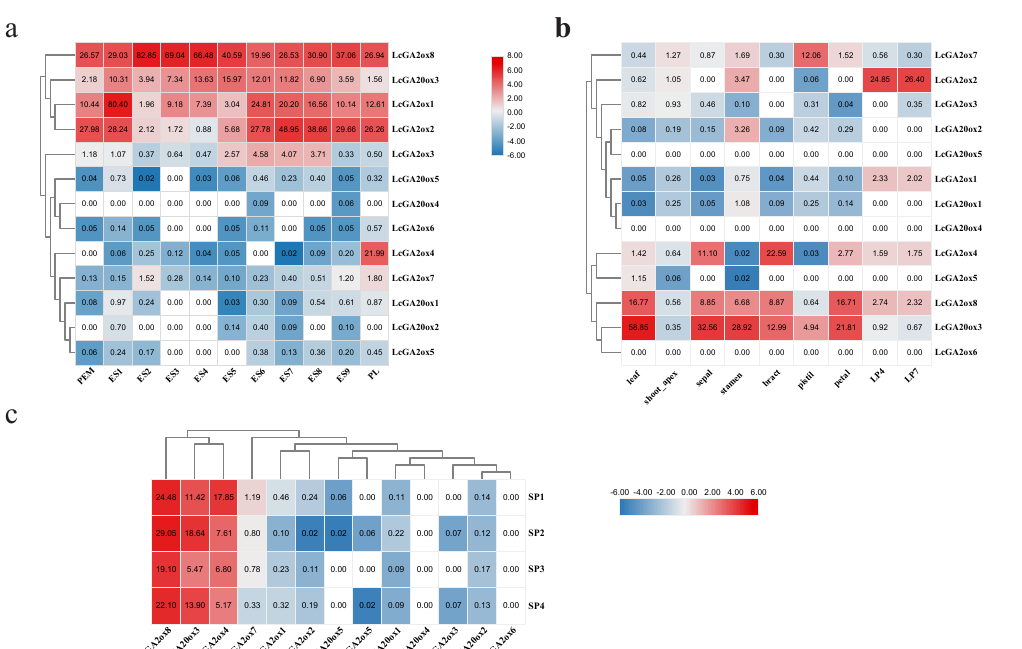
Figure 9. The LcGA20ox and LcGA2ox gene expression profiles in different organs. Two or three biological repeats were shown in the heatmap except bract. The transcripts per million (TPM) was used to indicated the gene expression level. PEM: embryogenic callus; ES1: after 10 days of liquid culture; ES2: two days after sieving; ES3: one day after ABA treatment; ES4: three days after ABA treatment; ES5: globular embryo; ES6: heart shaped embryo; ES7: torpedo embryo; ES8: immature cotyledon embryo; ES9: mature cotyledon embryo; PL: planta; SP1-4: the stage of petals development. ( a ) and ( c ) respectively represent the LcGAox gene expression level during somatic embryogenesis of hybridization liriodendron and the development stage of petal. These RNNA-seq data belong to the lab not publish the data. ( b ) represents the LcGAox gene expression level in different organs, and the accession numbers has listed in the material and methods 4.5. The expression levels of the genes were expressed by Transcripts Per Million